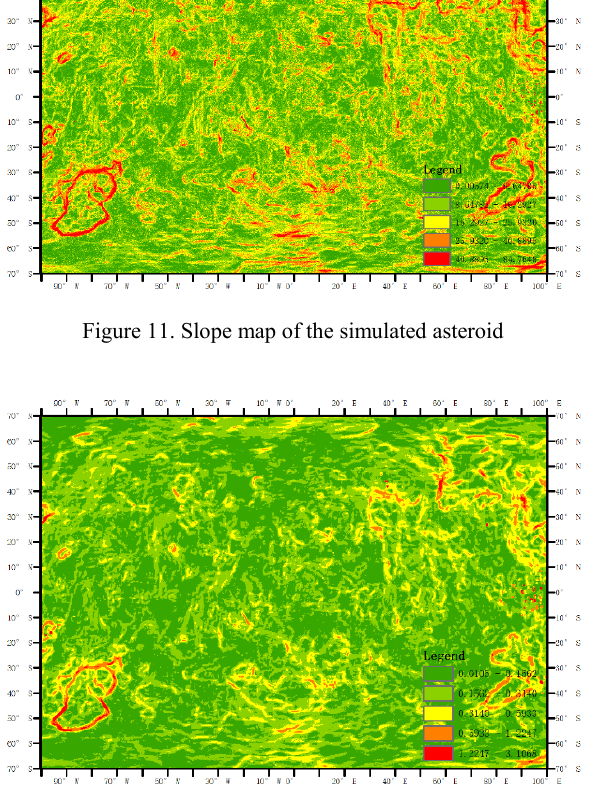
Figure 12. Elevation step of the simulated asteroid The slope threshold was set at 15 degrees and the threshold of the elevation step was set at 0.3 meters. Then we compared slope results and elevation step results with the two thresholds. As a result, we obtained the pixels labelled as obstacle and non- obstacle. Finally, according to the distribution of labelled pixels, we generated the obstacles map as Figure 13 shows. In Figure 13, red colour represents obstacle and green colour represents non- obstacle. Based on the calculated obstacle distribution map, we can assess the landing/sampling area of the lander.